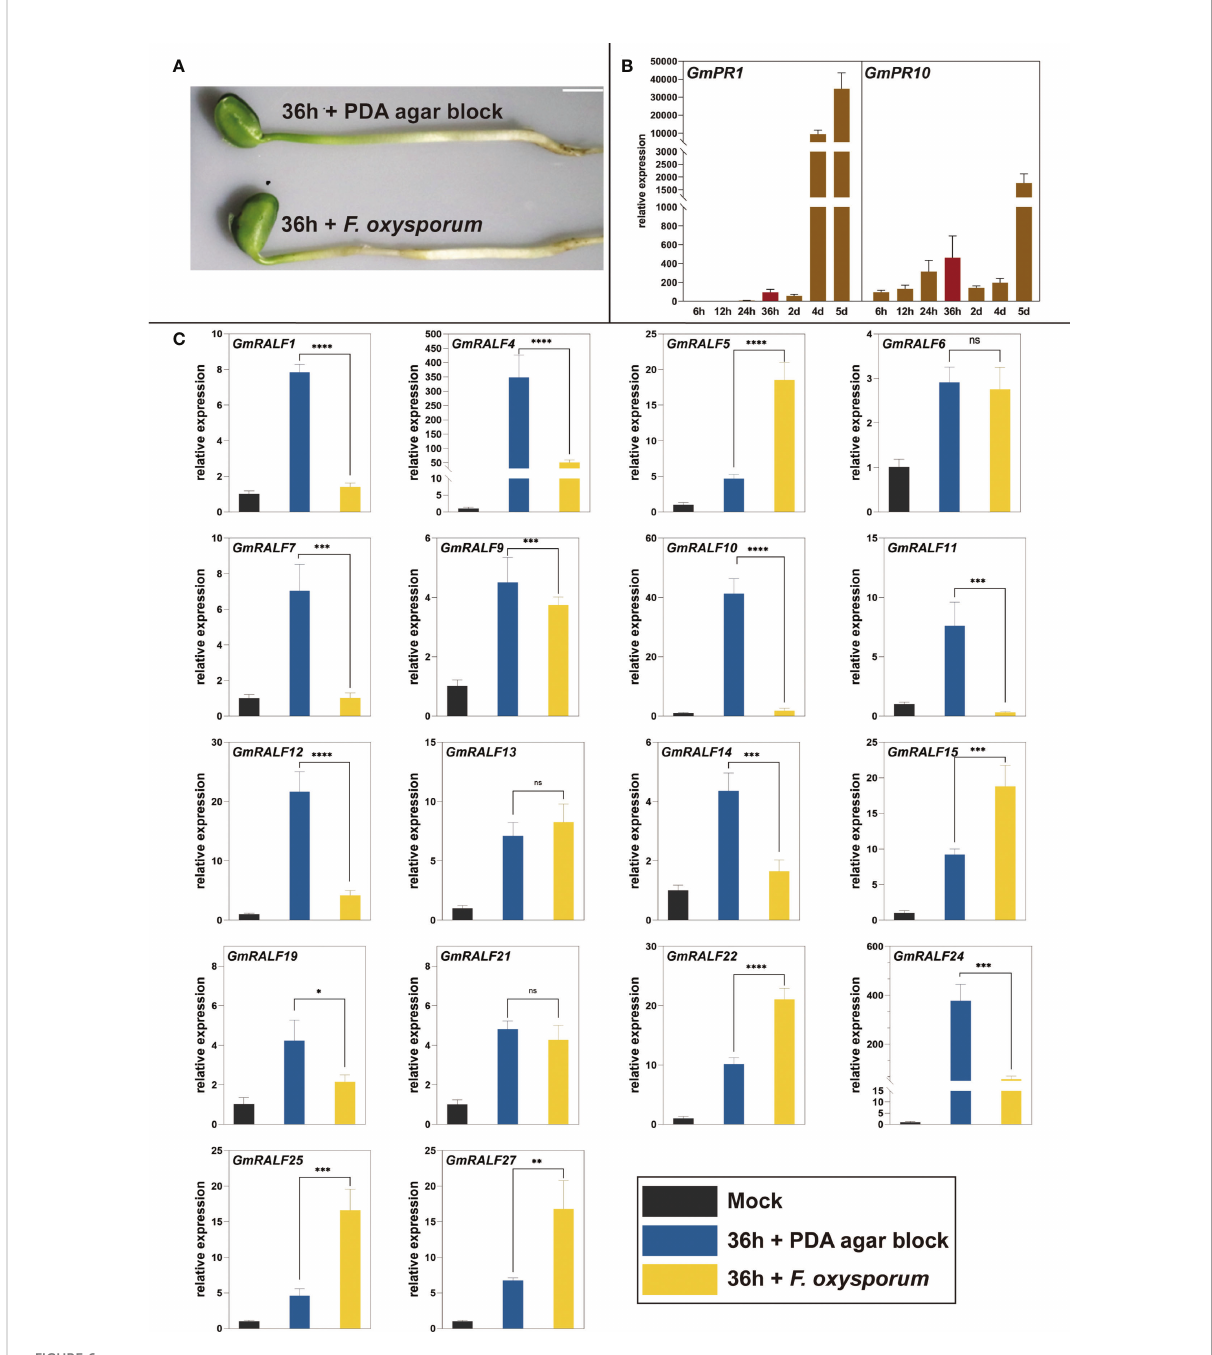
FIGURE 6 qPCR analysis of GmRALFs in response to F. oxysporum infection. (A) Disease phenotypes of Jiuyuehuang and control at 36 h after inoculated with F. oxysporum. (B) Relative expression level of immune marker genes in soybean treated with F. oxysporum . (C) Expression patterns of the selected GmRALFs after being treated with F. oxysporum . Mock : uninoculated soybean seedlings at 0 h; 36 h + PDA agar block : soybean seedlings were treated with PDA medium agar block for 36h; 36 h + F. oxysporum : soybean seedlings were inoculated with F. oxysporum for 36 h Data were normalized to the GmActin gene, and the experiments all above were repeated three times along with at least three independent repetitions of the biological experiments. Scale bar represents 1 cm. Error bars indicate the standard error. Asterisks indicate statistically signi fi cant differences (*P < 0.05, **P < 0.01, ***P < 0.001, ****P< 0.0001, ns, no signi fi